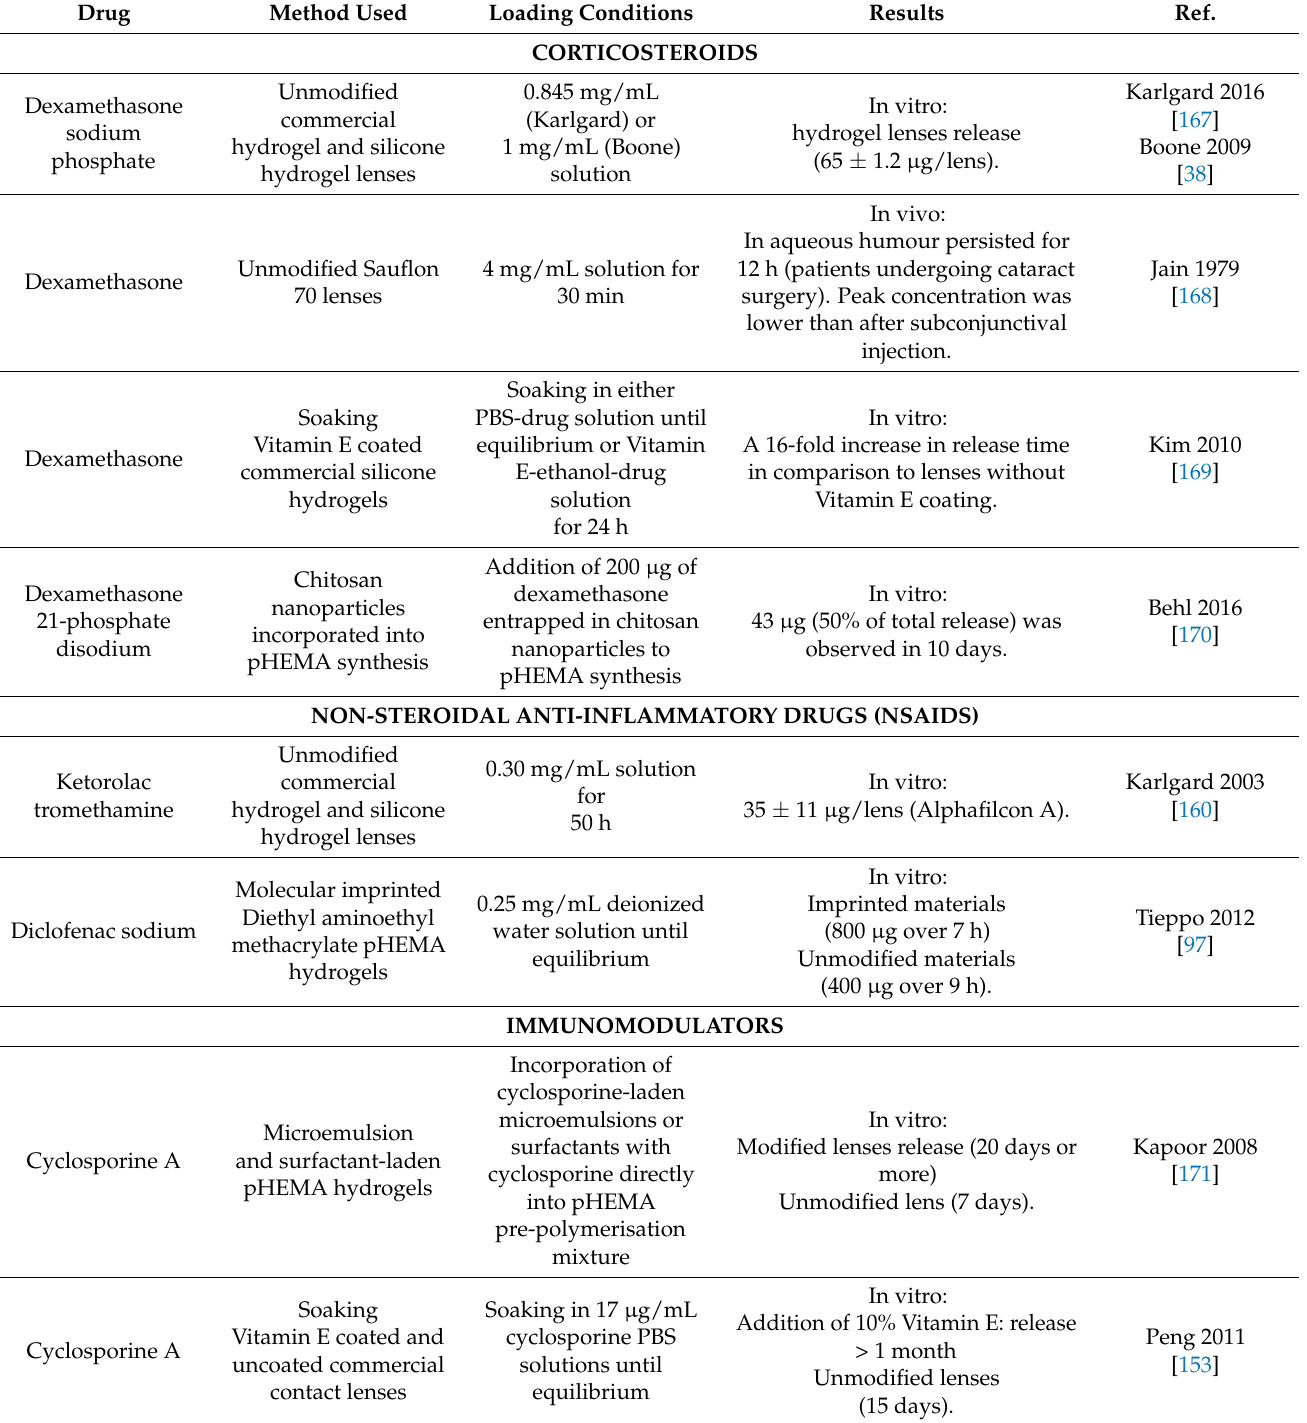
Table 4. Selected CL drug delivery experiments investigating anti-inflammatory agents [16,155]. Drug Method Used Loading Conditions Results